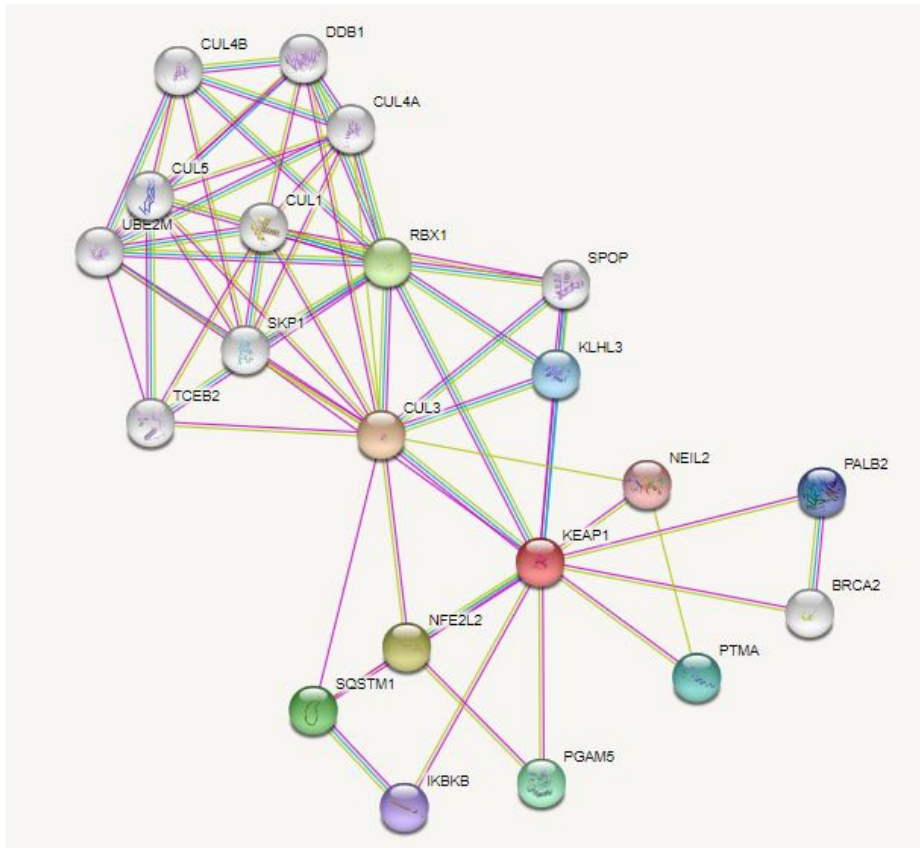
Figure 2. PPI (protein–protein interaction) network of Keap1. In DisGeNet (https://disgenet.org/, accessed on 29 September 2022), the association of Keap1 and AMD was verified. The PPI network for Keap1 was then analyzed using the STRING database (https://string-db.org/, accessed in 29 September 2022); the interactions were analyzed in Homo sapiens , setting the confidence basis to 0.4 and selecting only the physical interactions.